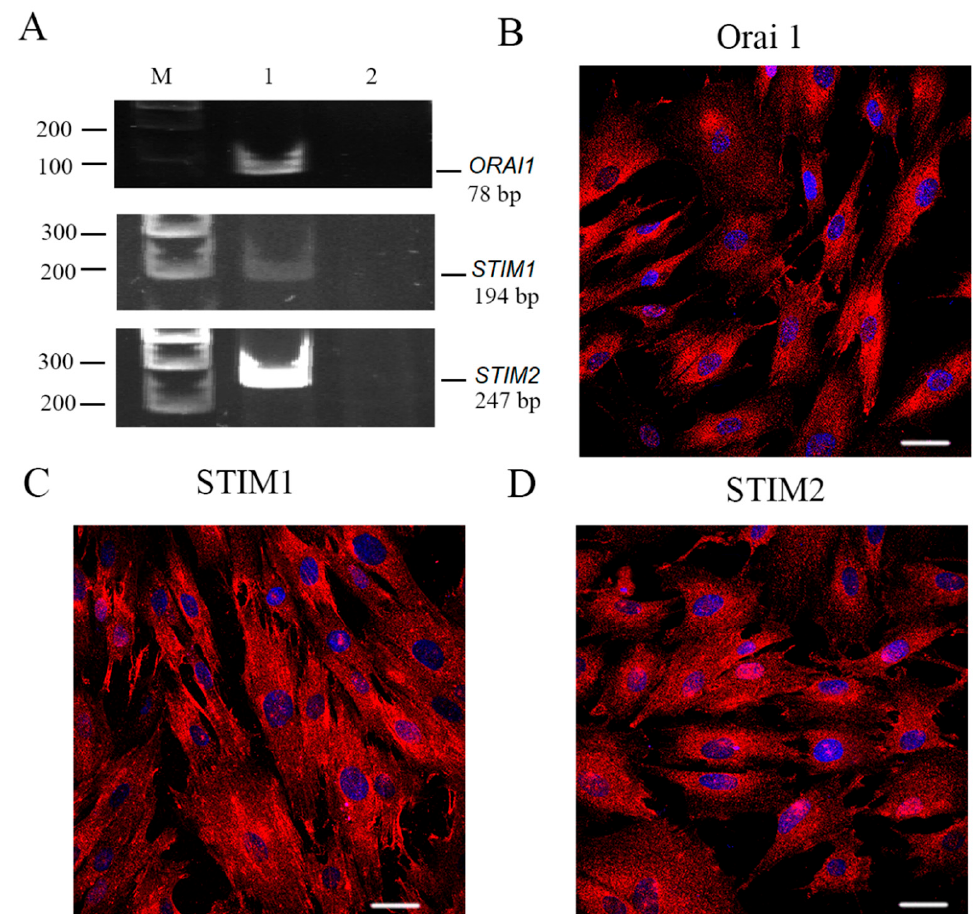
Figure 3. ORAI1 , STIM1 and STIM2 expression in human eMSCs. ( A ) RT-PCR analysis of ORAI , STIM1 and STIM2 expression in eMSCs. M—size marker. Line 1—primers specific for ORAI1 , STIM1 and STIM2 amplified the PCR products of the expected sizes (78, 124 and 247 bp, correspondingly). Line 2—RT-PCR negative control in which reverse transcriptase was omitted. Shown are cropped gels with enhanced contrast. Original gel is shown in Supplementary Figure S5. The distribution of ORAI1 ( B ), STIM1 ( C ) and STIM2 ( D ). Immunoreactivity in eMSCs was examined with confocal microscopy. No staining of the cells was observed after incubation of the cells with only fluorescent secondary antibodies (Supplementary Figure S2). Scale bar is 50 µ